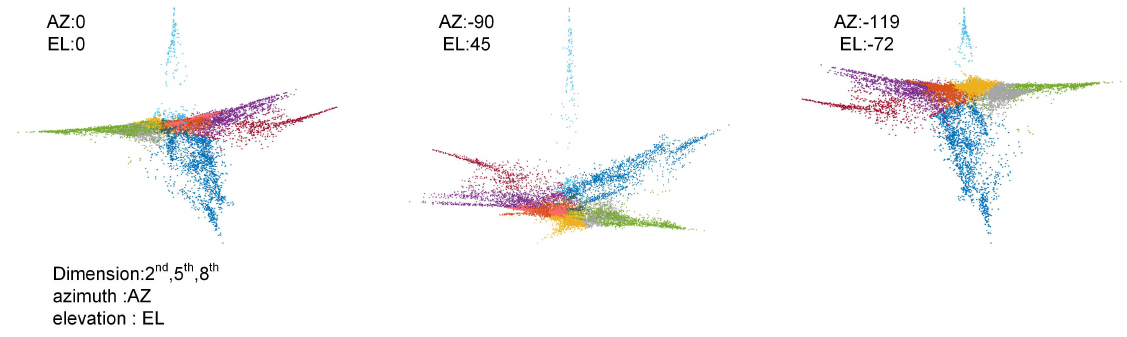
Figure A2. The 3d plot of the manifold from different angles for the 10 CCPs in Figure 2A.